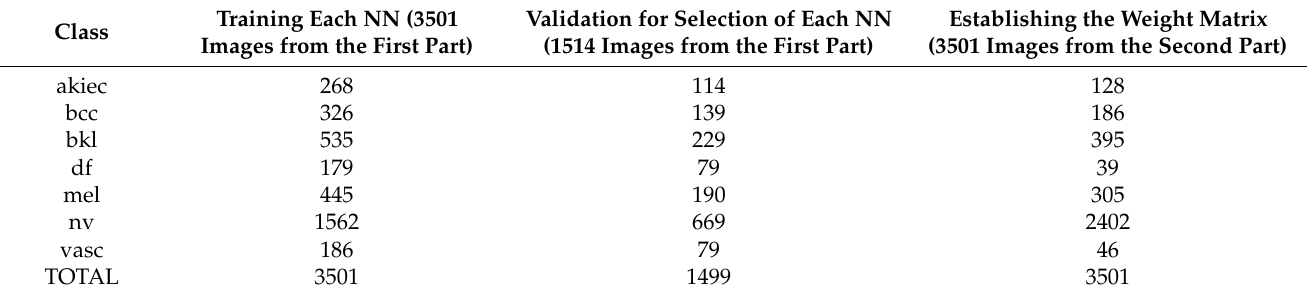
Table 2. The images used per class with augmentation (only training phase) for the non-nv. Training Each NN Class